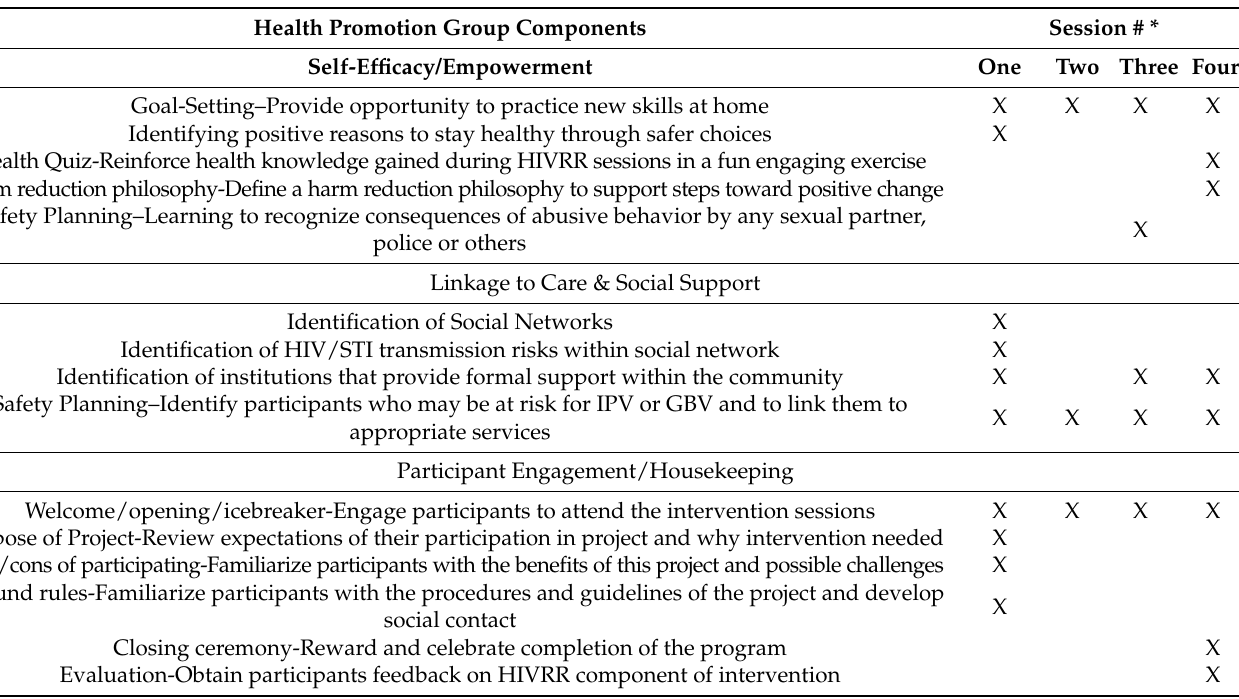
Table 2. Health promotion components integrated into HIVRR sessions